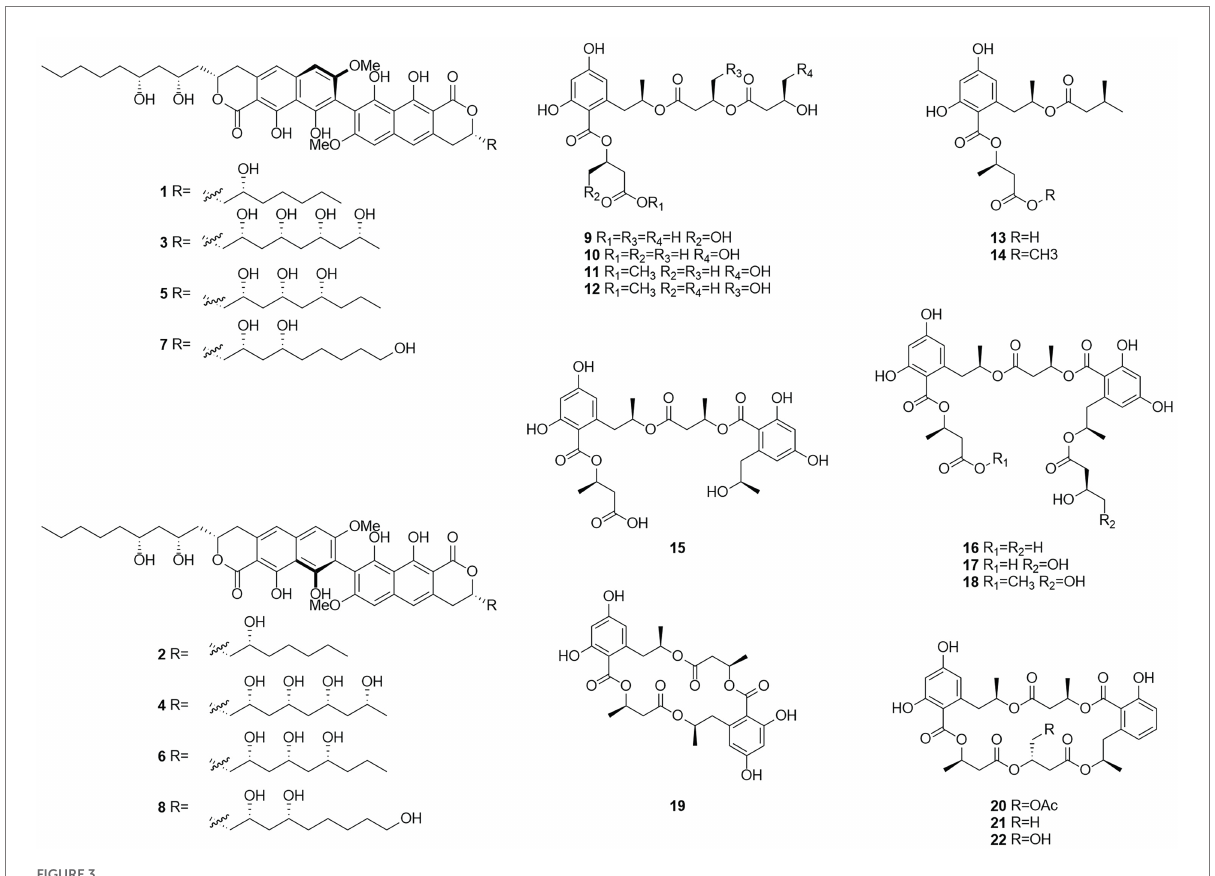
FIGURE 3 Chemical structures of compounds 1–22